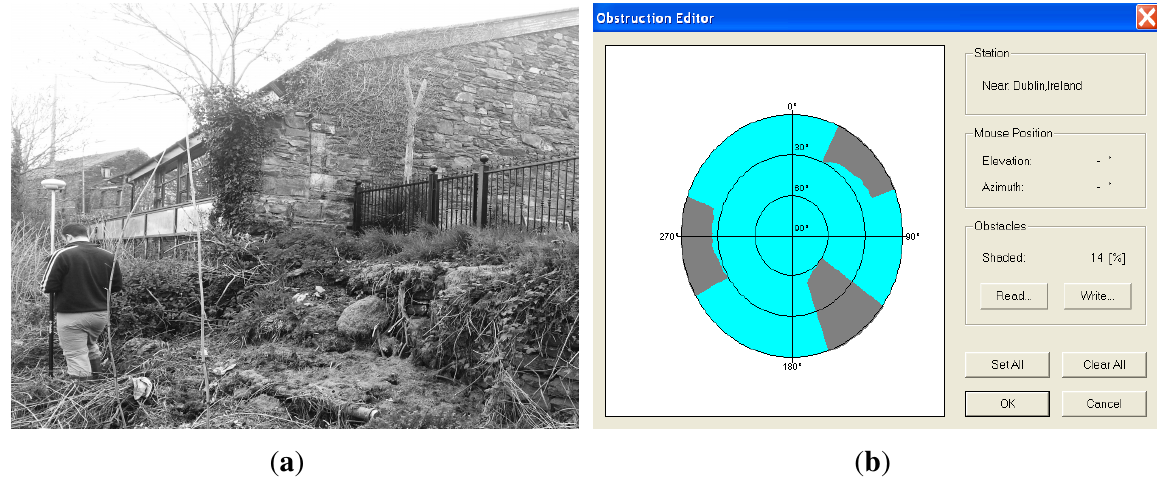
Figure 1. GNSS Survey Planning ( a ) GNSS signal during topographic surveys can be obstructed by surrounding objects ( b ) specifying portions of the horizon in Trimble Planning where obstructions are present to simulate buildings or other vertical